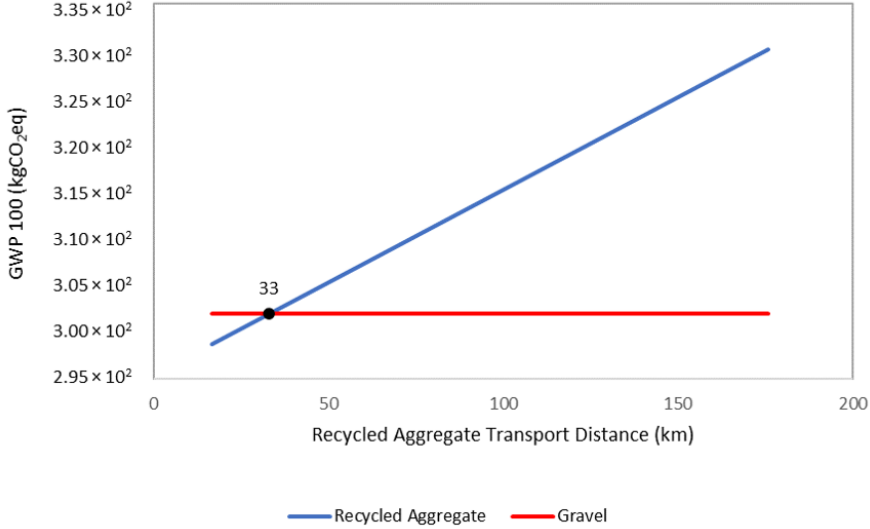
Figure 16. Correlation between global warming (GWP) emissions and the transport distance of the recycled aggregates.